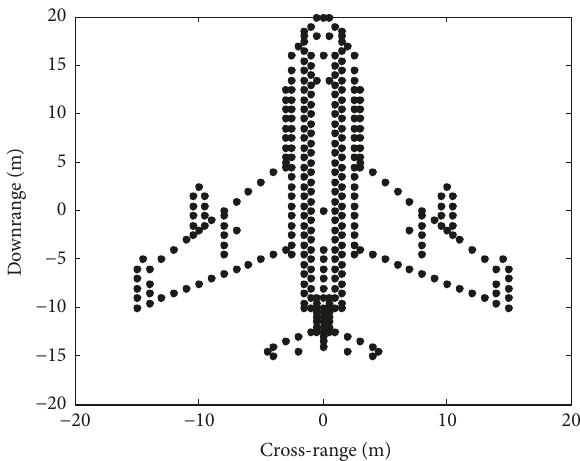
Figure 7: Model of Yak-42 plane with 330 scatterers.